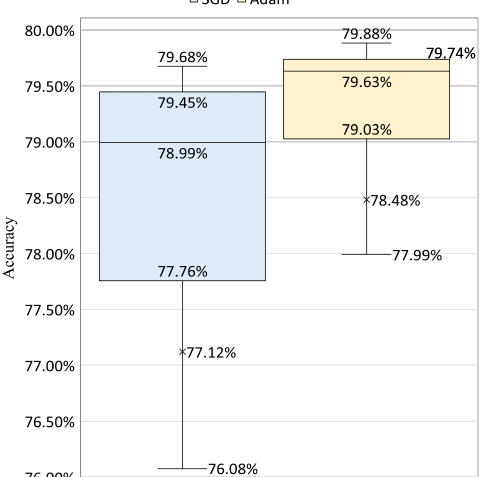
Figure 8. The validation accuracy comparison between SGD and Adam over 150 epochs using transformers-based architecture.